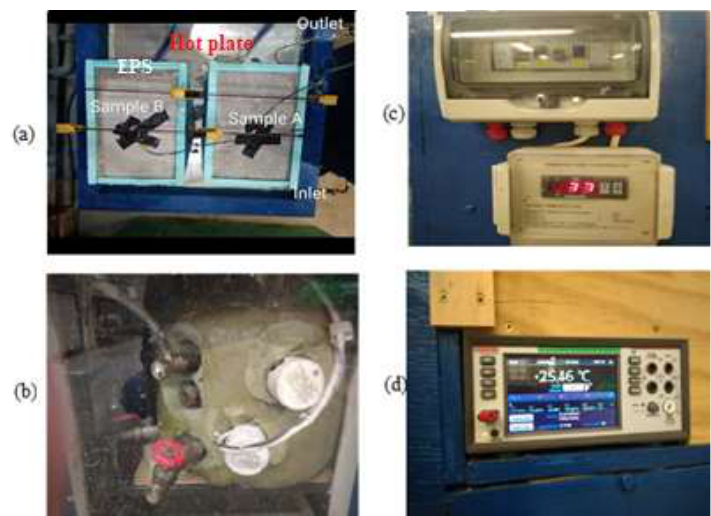
Figure 1. Experimental test rig containing ( a ) hot plate and samples with insulation EPS, ( b ) hot water storage tank and pump, ( c ) tank set temperature control, ( d ) data acquisition system.